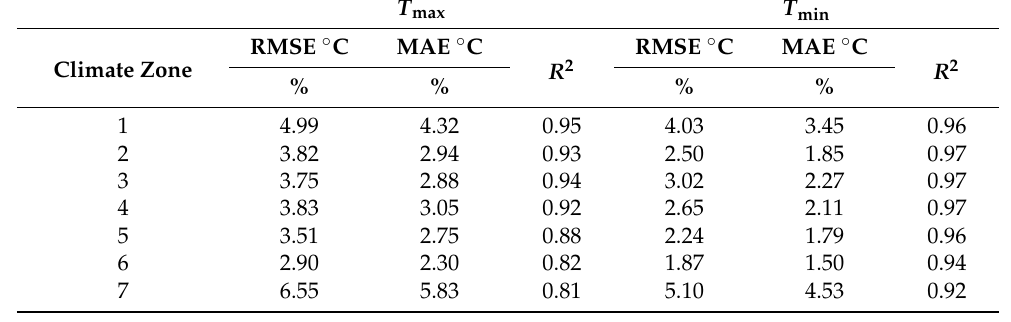
Table 2. Statistical indicators of maximum and minimum temperatures in different climate zones of China.